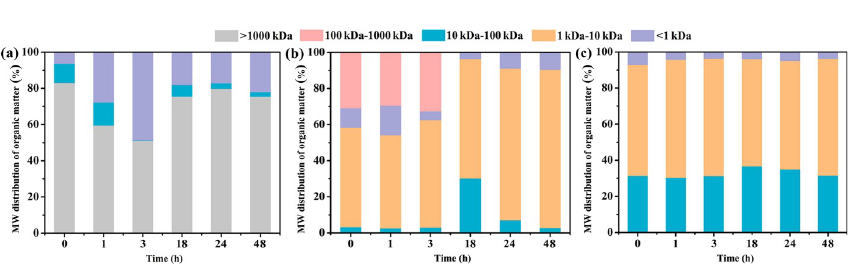
Fig 4. Molecular weight (MW) distributions of organic matter in the (a) pure HPG (b) simulated fracturing fluid-0 and (c) simulated fracturing fluid. Five MW fractions ( < 1 kDa, 1–10 kDa, 10–100 kDa, 100–1000 kDa, and > 1000 kDa) were identified in the pure HPG, simulated fracturing fluid-0 and simulated fracturing